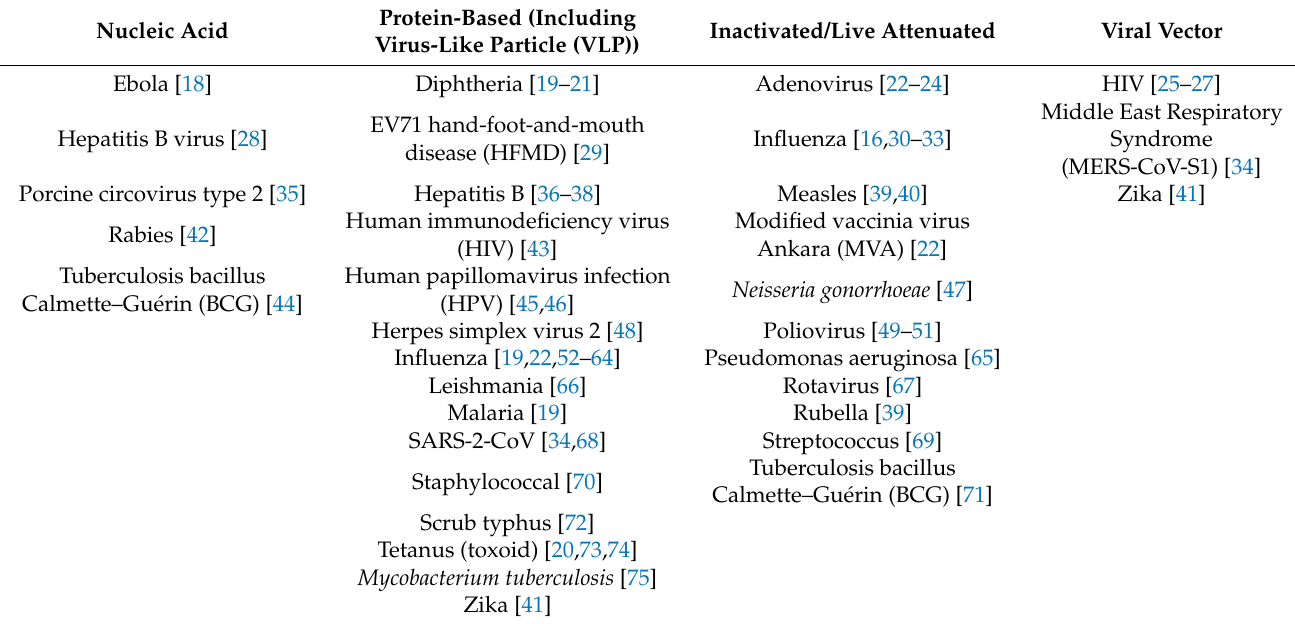
Table 1. Vaccines studied using dissolvable microneedle